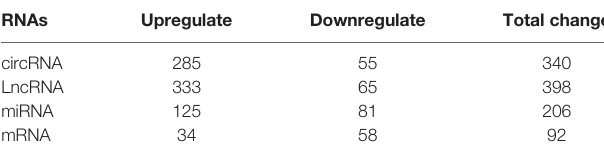
TABLE 1 | Numbers of differentially expressed